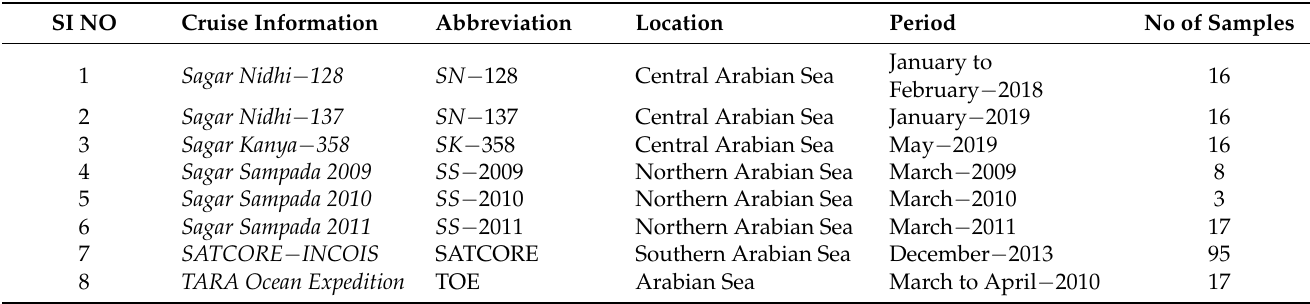
Table 1. Summary of the Arabian Sea cruises and in situ